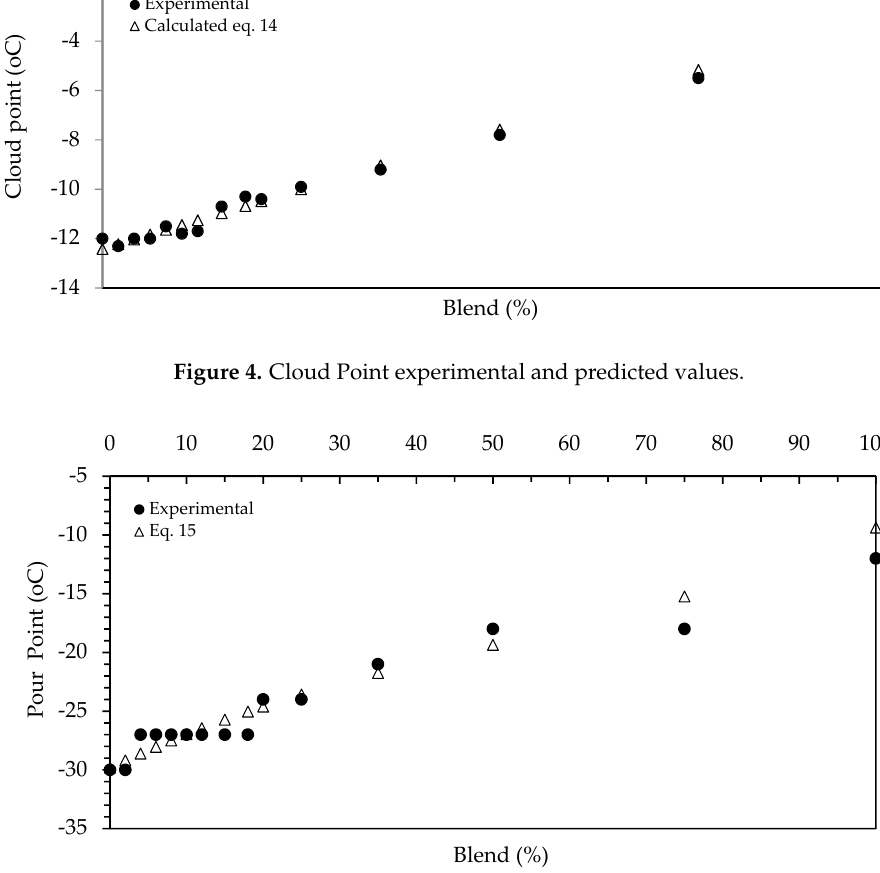
Figure 5. Pour Point experimental and predicted value.